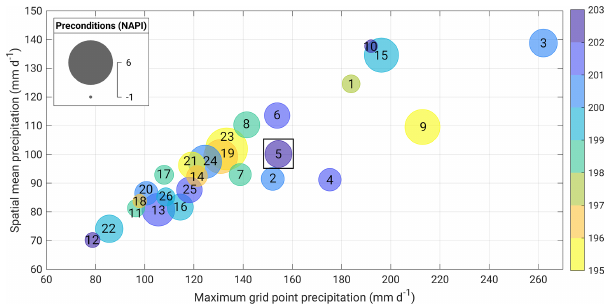
Figure 3. Bubble plot of the most extreme precipitation events in Germany according to the HPE crit based on daily HYRAS-DE data (1951 to 2021). The maximum 24h grid point intensity within the HPE crit area A is given on the x axis; the y axis represents the spa- tially averaged 24h precipitation over A . The size of the bubbles (small inset legend at the top left) represents the preconditions using the normalized antecedent precipitation index (NAPI, see the Sup- plement), while the color indicates the decade of occurrence. The numbers give the ranking according to the HPE crit (see Table S2). The July 2021 event (ranked fifth) is marked with a rectangle. Figure 4. Relationship between precipitation totals and affected